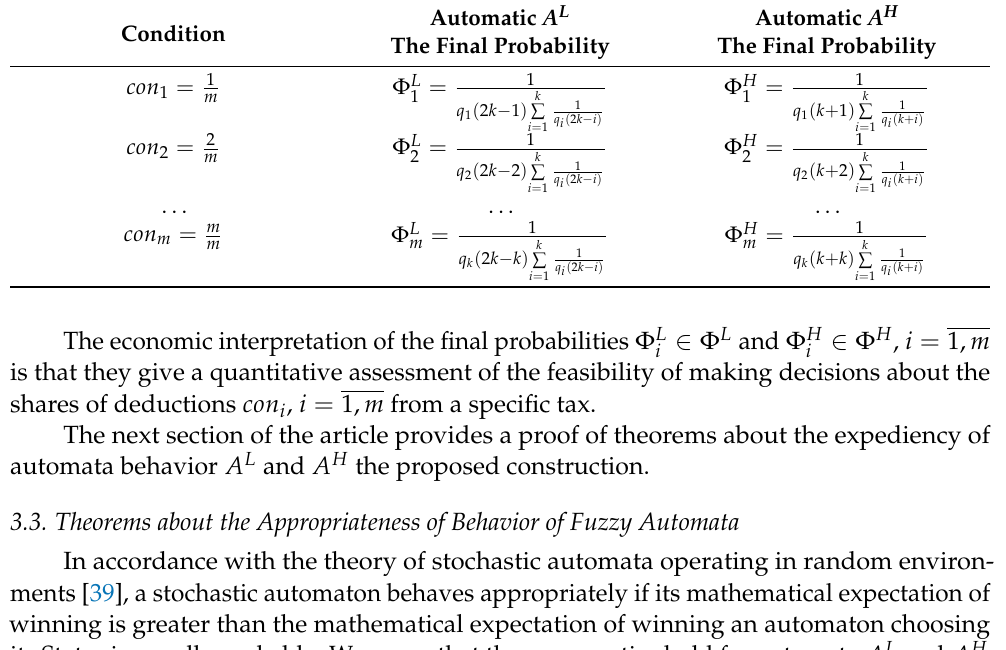
(cid:8) Φ L (cid:9) , Φ L , . . . , Φ L m and Φ H = 2 1